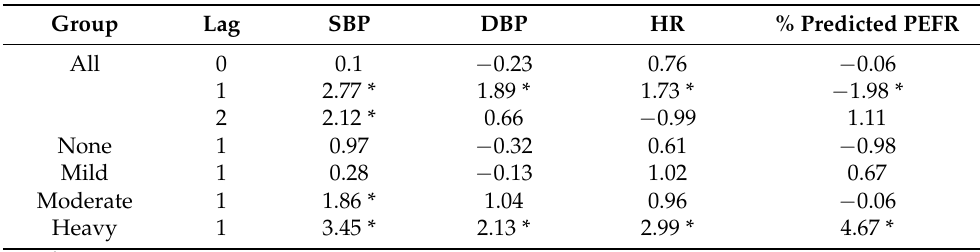
Table 4. Changes in health measurements resulting from an interquartile range change of fine particles levels in mixed-effects